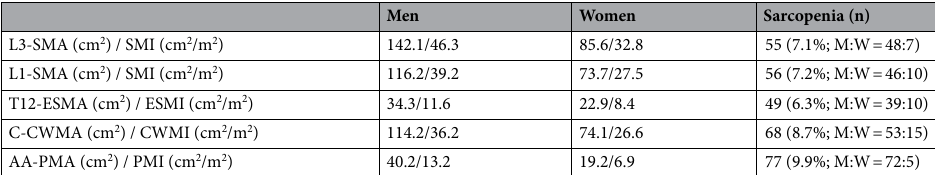
Table 2. The cut-offs to define sarcopenia in Asian population. SMA = skeletal muscle area (L3 = at 3rd lumbar vertebra level, L1 = at 1st lumbar vertebra level), SMI = skeletal muscle index (L3 = at 3rd lumbar vertebra level, L1 = at 1st lumbar vertebra level), T12-ESMA = erector spinae muscle area at 12th thoracic vertebra level, T12- ESMI = erector spinae muscle index at 12th thoracic vertebra level, C-CWMA = chest wall muscle area at carina level, C-CWMI = chest wall muscle index at carina level, AA-PMA = pectoralis muscle area just above aortic arch level, AA-PMI = pectoralis muscle index just above aortic arch level, M = men, W = women.